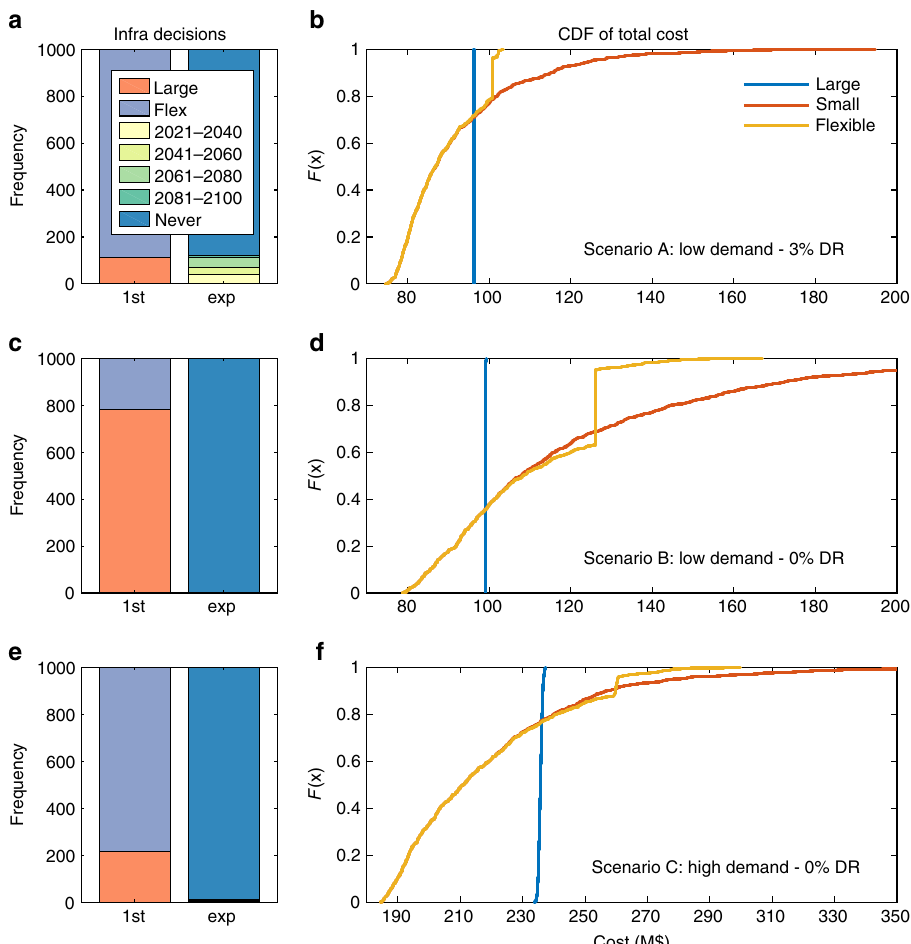
Fig. 5 Simulated infrastructure decisions and costs. a , b Planning scenario A (low-demand, discounting). c , d planning scenario B (low-demand, no discounting); e , f planning scenario C (high-demand, no